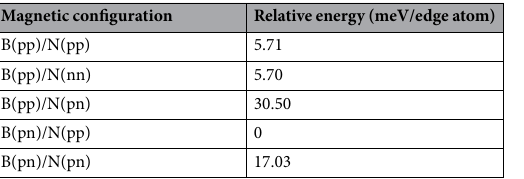
Table 1. Averaged energies of different edge magnetic configuration of zzBNNRs relative to the ground state